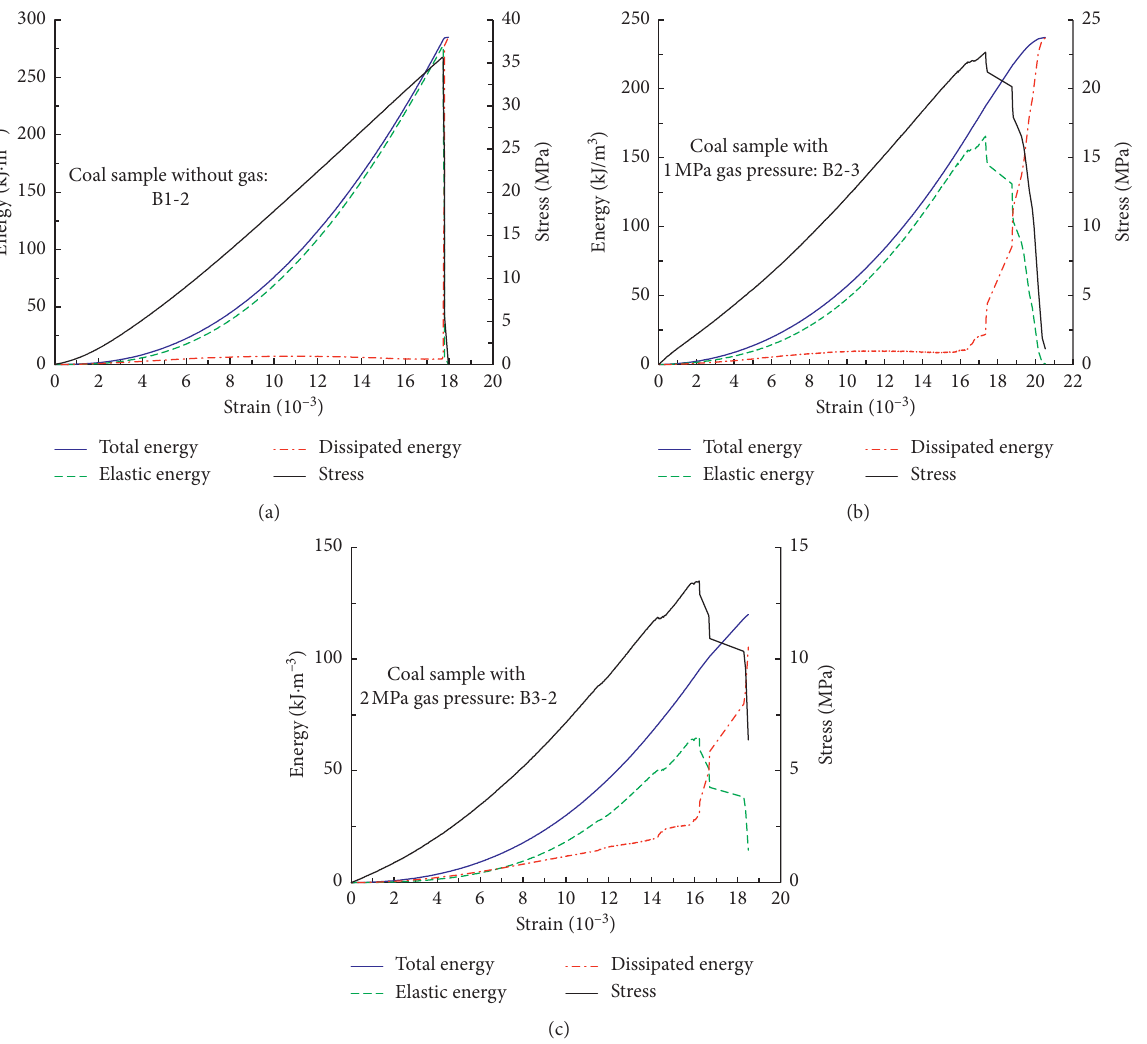
Figure 17: Energy evolution curve of coal samples of different gas pressures under uniaxial loading. (a) Coal sample without gas. (b) Coal sample with 1MPa gas pressure. (c) Coal sample with 2MPa gas